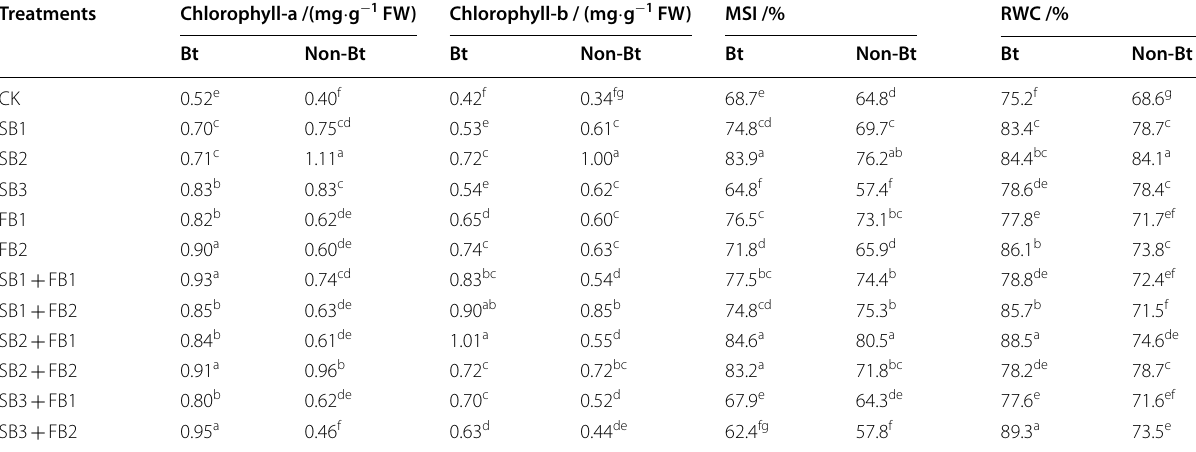
Values are means of three replicates with two plants per replicate (n SB1: 1 mg kg − 1 B through soil application; SB2: 2 mg · spray; SB1 FB2: 1 mg kg − 1 B 0.4% B foliar spray; SB2 + · + B